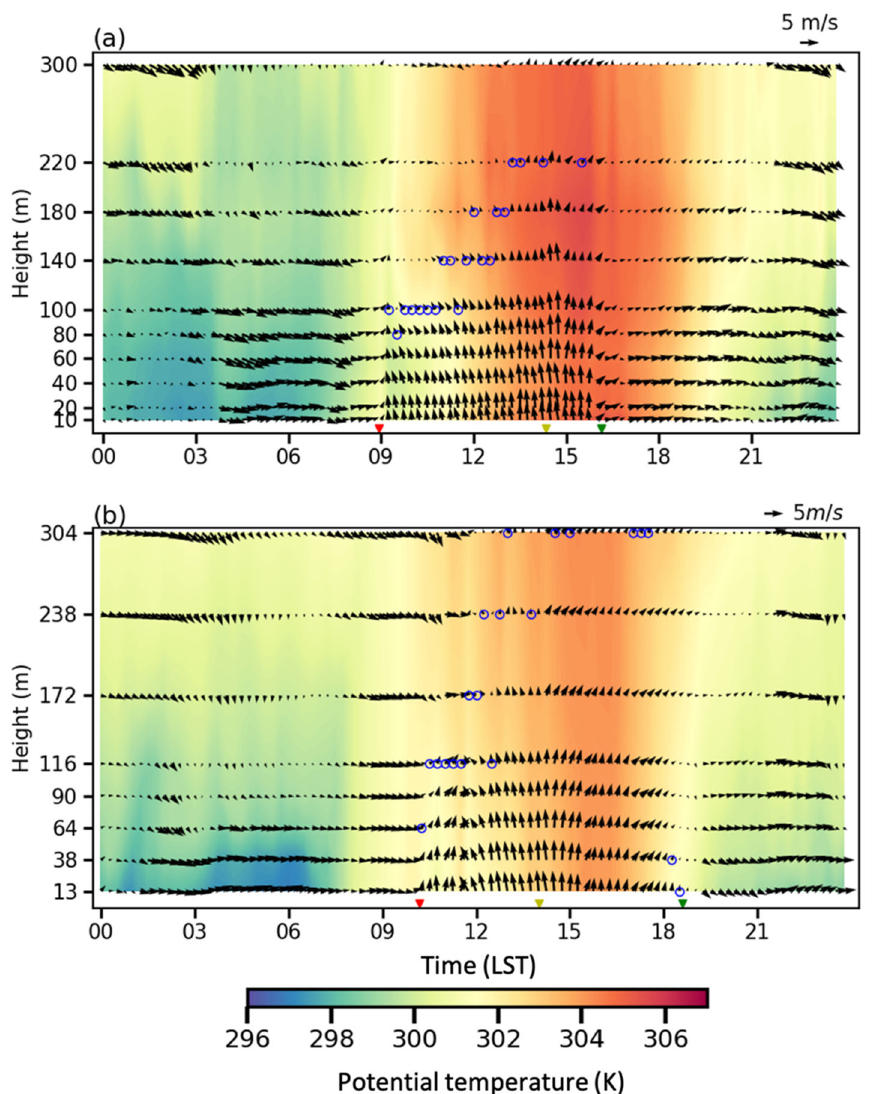
Figure 8. Time–height cross-section of potential temperature (contour) and wind vectors of ( a ) BSWO tower observations and ( b ) default simulation (S04V). The time interval of the wind vector is 15 min. Red, yellow, and green inverted triangles on the x -axis indicate time of onset, maximum sea-breeze intensity, and cessation, respectively. Open blue circles indicate the sea-breeze depth.